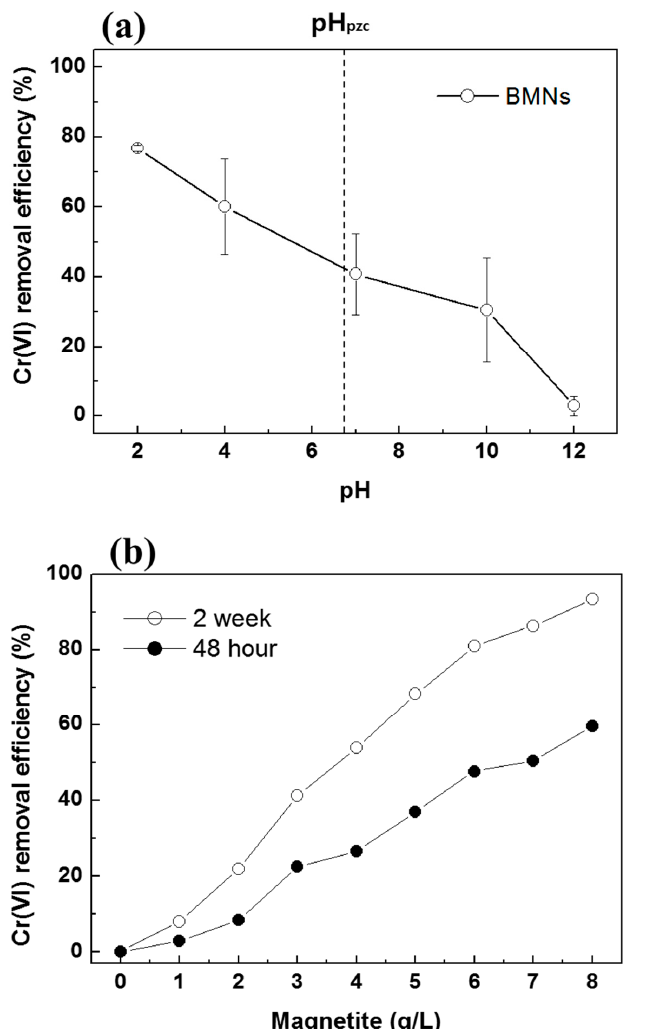
Figure 5. Cr(VI) removal efficiency by BMNs at ( a ) different pH values of solutions or ( b ) different reaction time in Cr(VI)-contaminated groundwater.